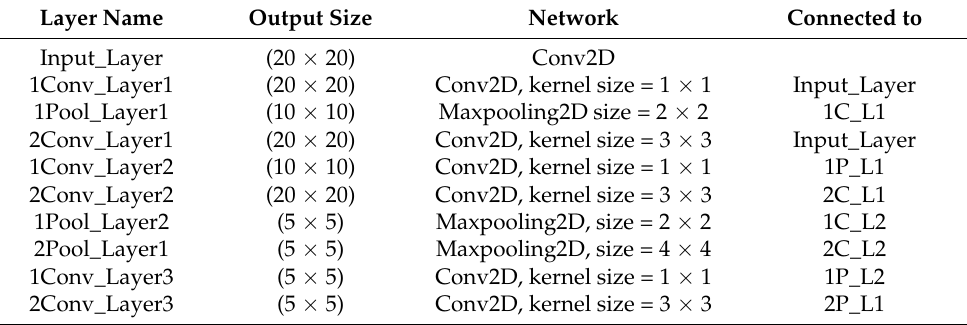
Table 2. Summary of the MS-CRNN